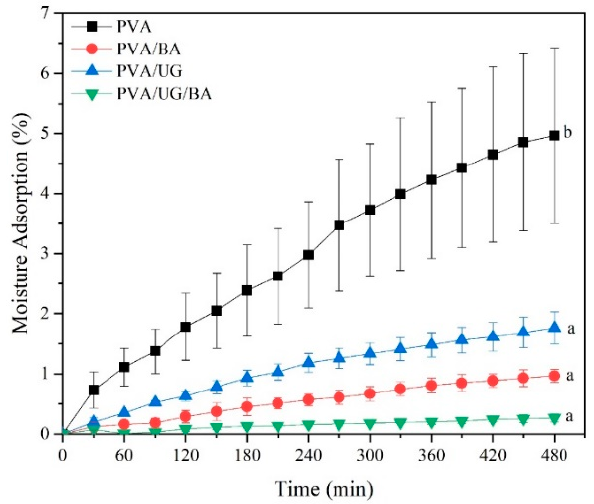
Figure 7. Average moisture absorption value of films. A significant difference in mean values ( p ≤ 0.05) is indicated with different letters (a, b).